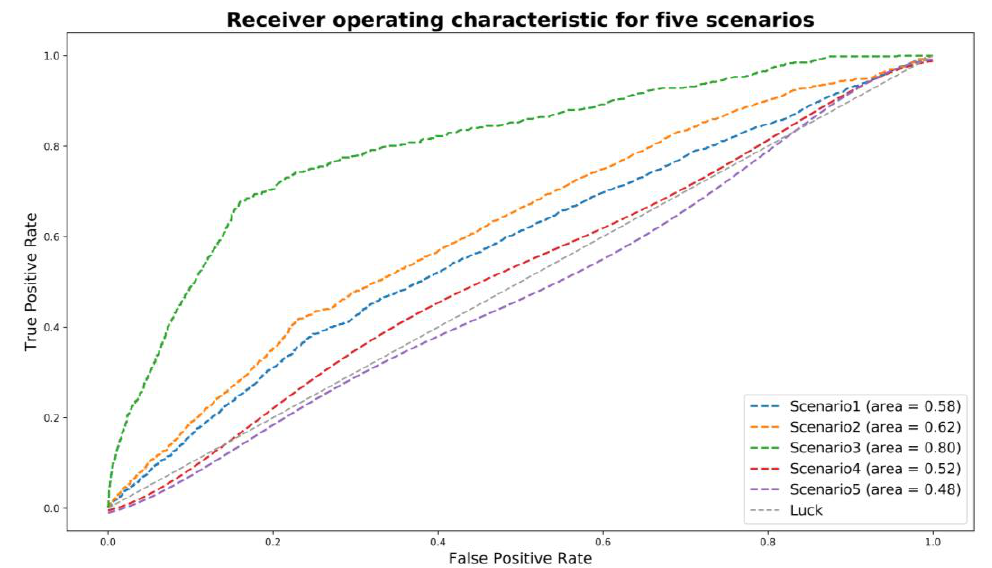
Figure 5. ROC curve for five labeling scenarios for model D development.